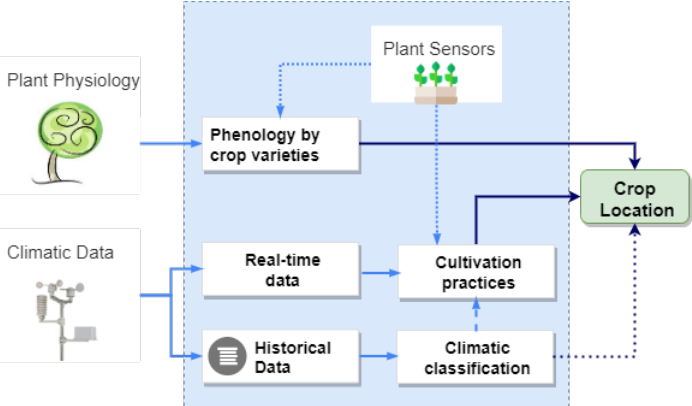
Figure 1. Data sets used and expected